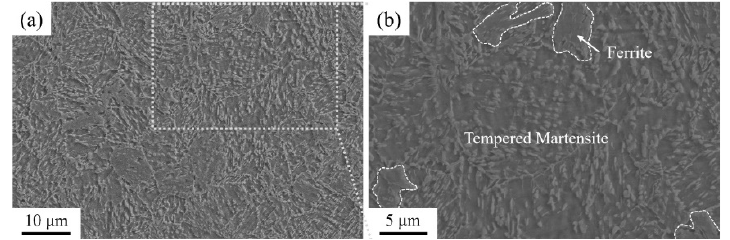
Figure 3. ( a ) SEM image of the HSLA steel; ( b ) enlarged SEM image of the selected area enclosed by the dashed line rectangle in ( a ).